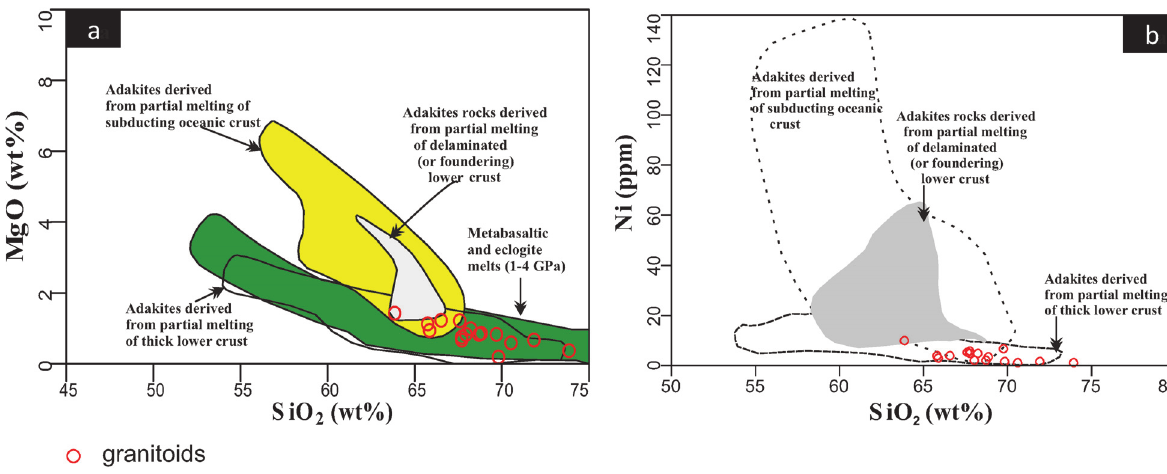
Fig. 12. (a) SiO 2 vs Mg# for the felsic rocks. Boundaries are from Rapp et al. (1999) and Smithies & Champion (2000). (b) SiO 2 vs Ni. Boundaries are from Wang et al. (2006).